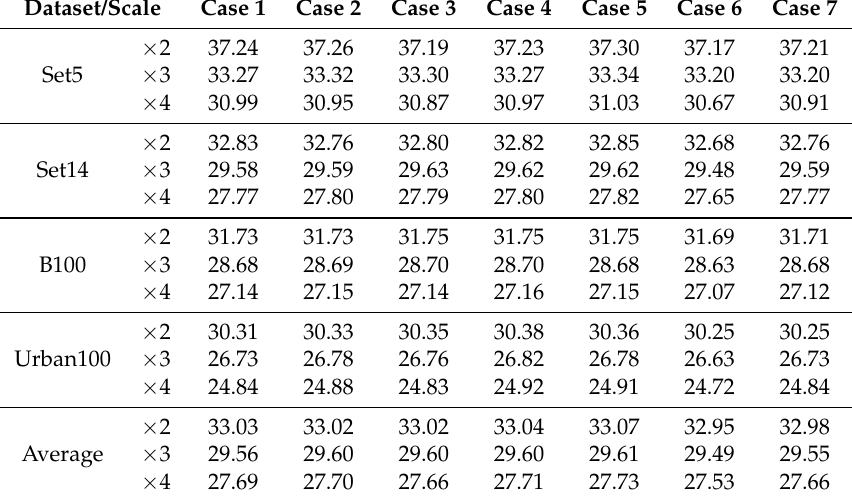
Table 2. Comparison of PSNRs of the proposed method with different combinations of k , n , and λ i